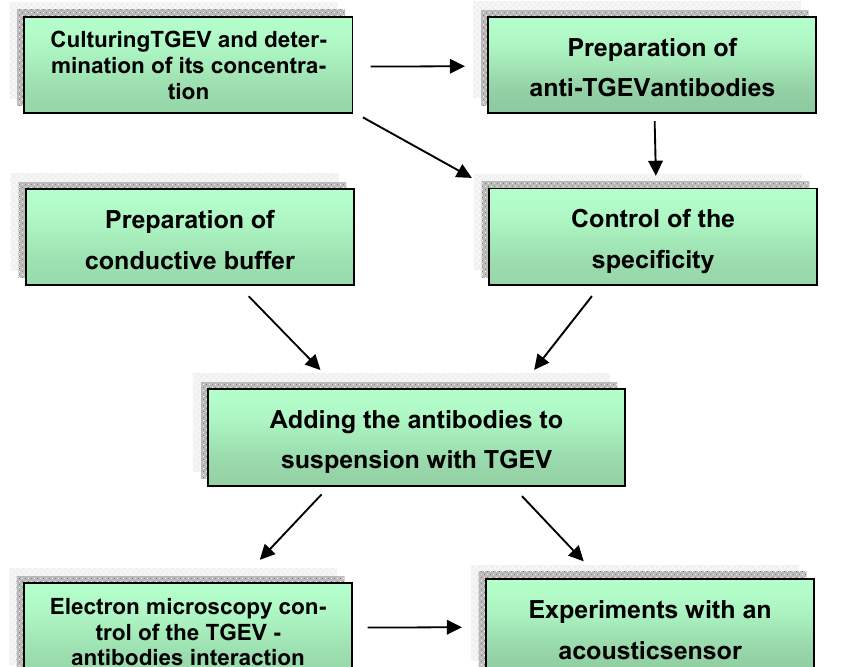
Figure 2. General scheme of the experiment.